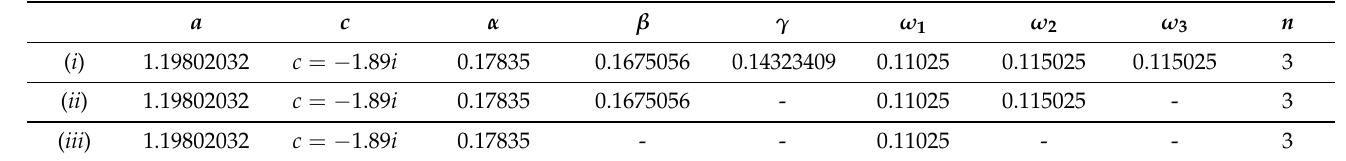
Table 1. The parameters used in Figure